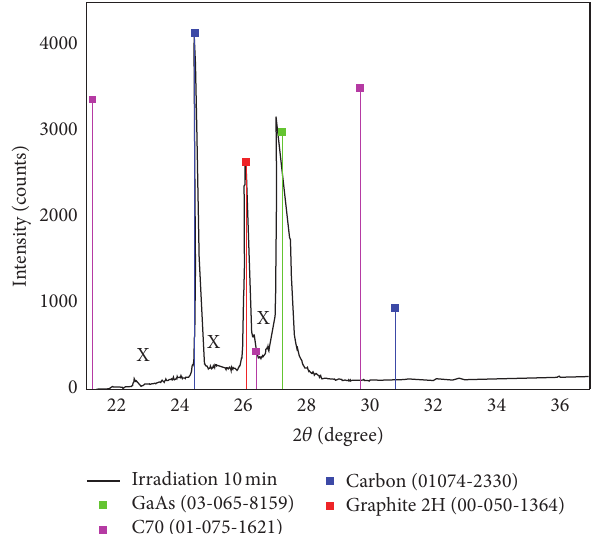
Figure 4: X-ray diffractogram of the film obtained with a 10min